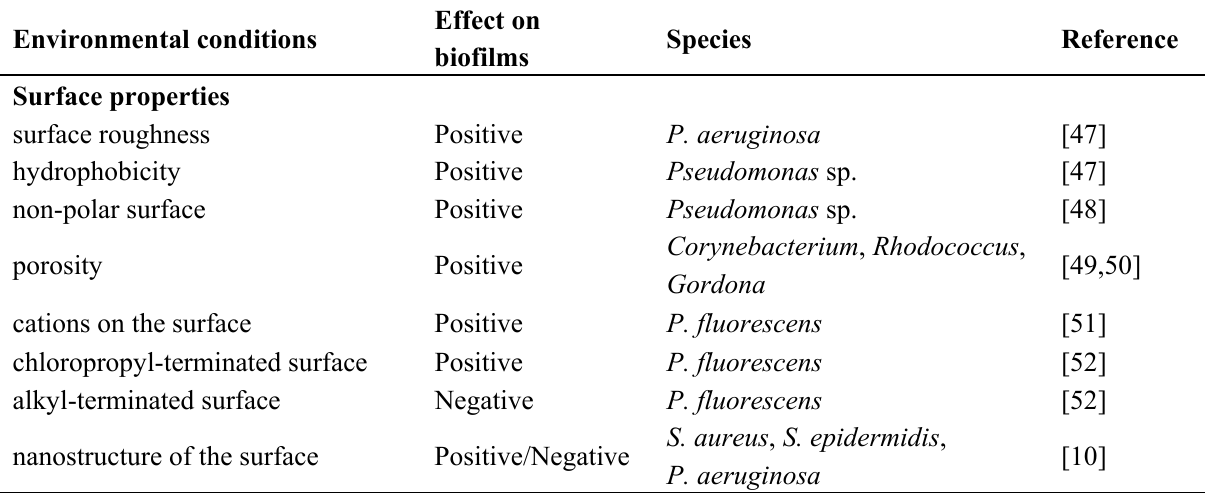
Table 1. Effects of the environmental conditions on biofilm